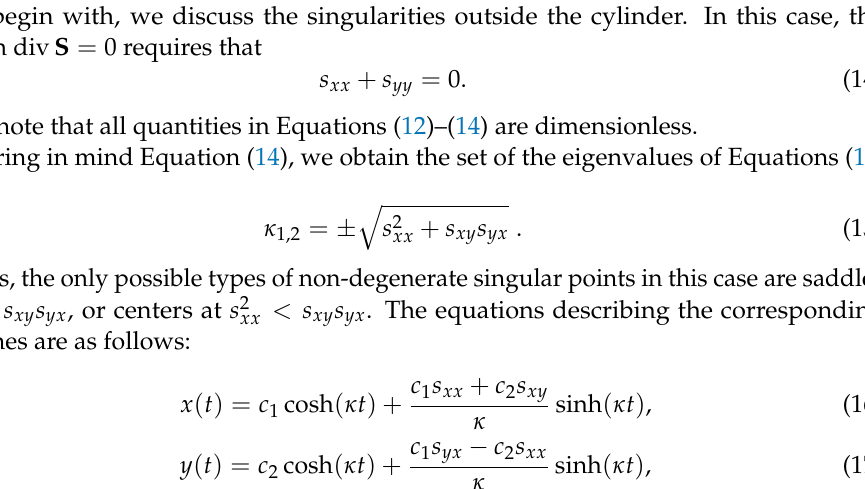
Figure 2. Mutual orientations of the cylinder and k , E , H vectors of the incident wave. TE polarization ( a ), TM polarization ( b